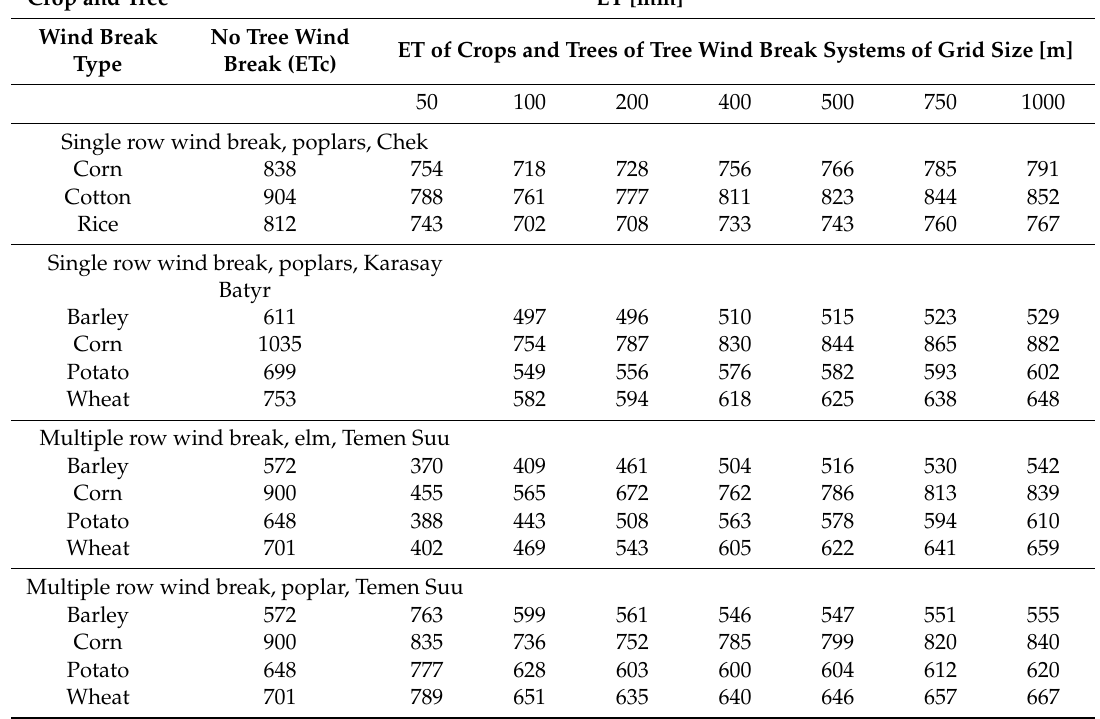
Table 6. Water consumption–evapotranspiration (ET) of crops without tree wind breaks (ETc) and with tree wind breaks of di ff erent grid